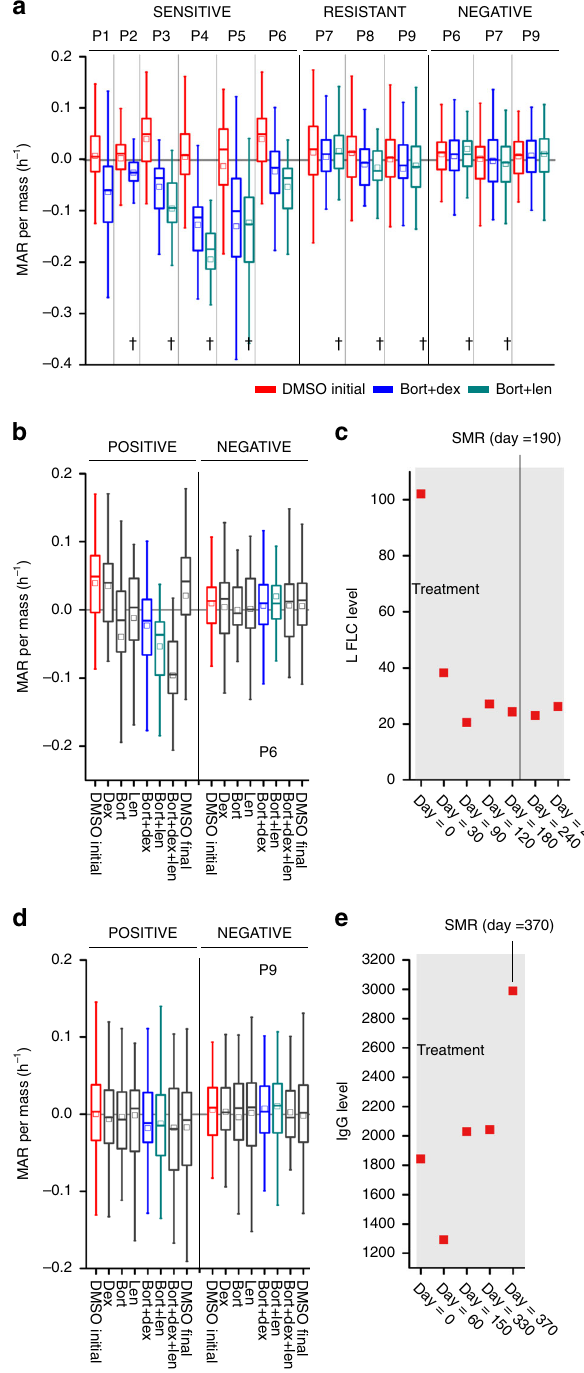
P9 is shown for control and treatment group under single, double, and triple lenalidomide. c , e Clinical test results: L FLC and IgG levels for P6 and P9, determined at different time points before and after